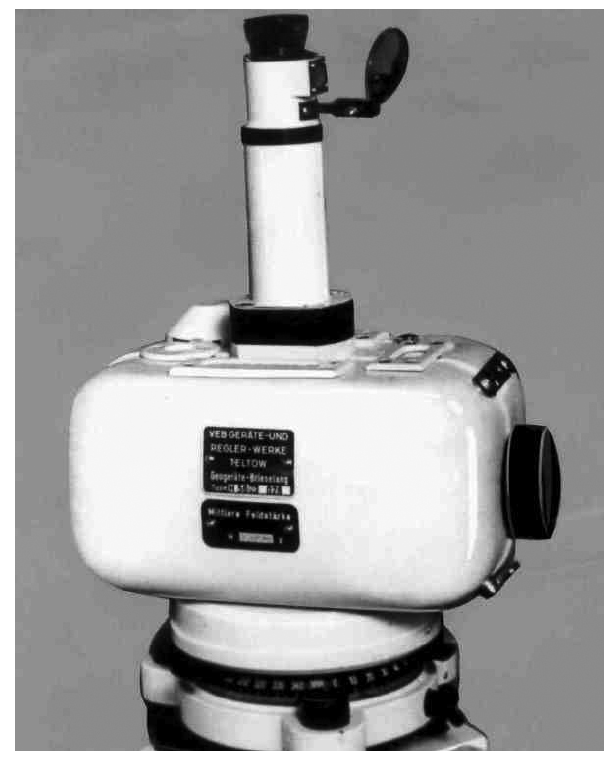
vations of the ionosphere with a worldwide unified schedule were again